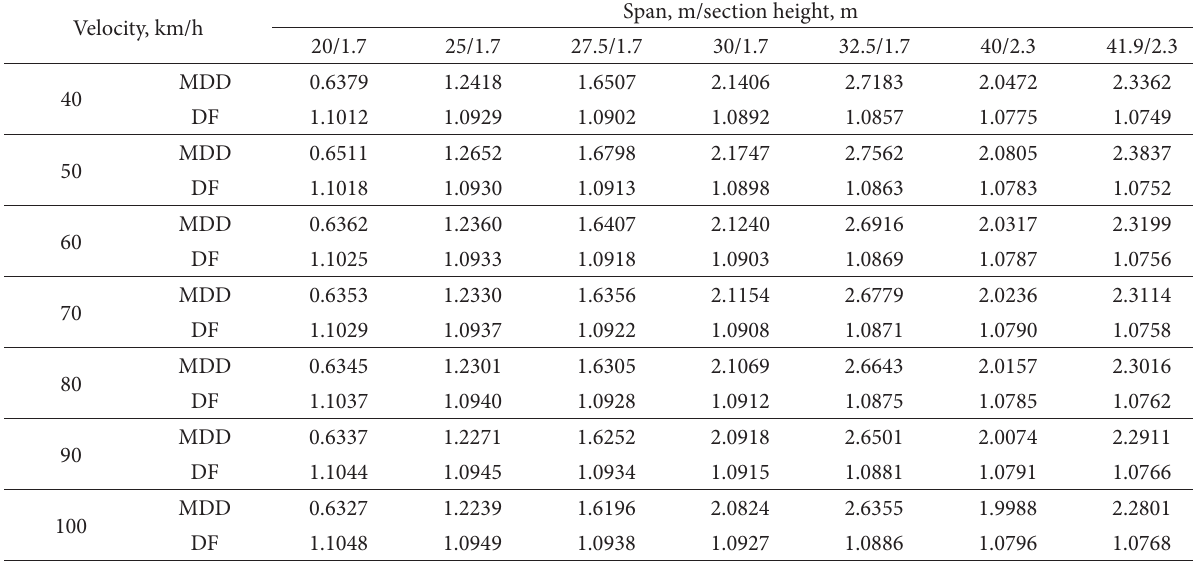
Table 2. Comparison of theoretical dynamic responses with electromagnetic force Velocity, km/h